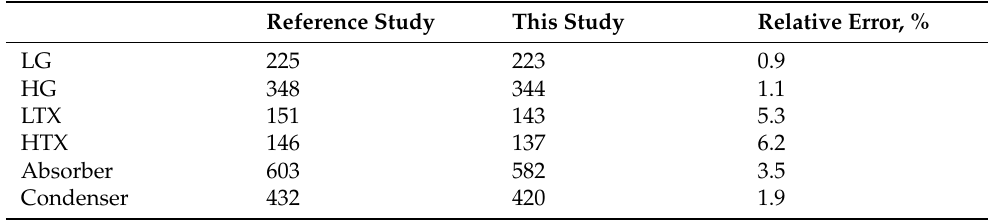
Table 5. Heat capacities and relative errors of components.